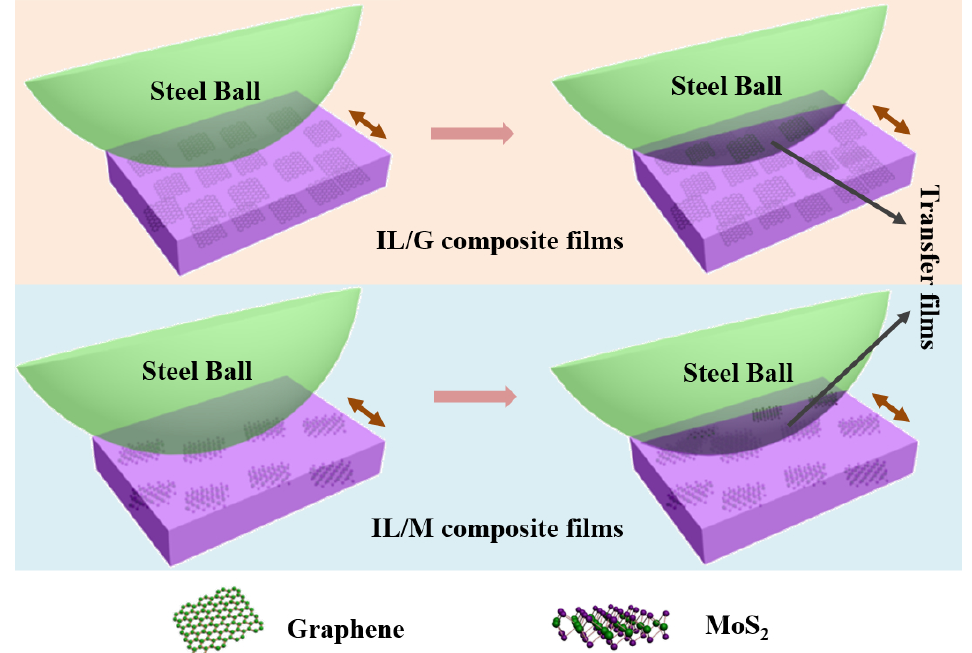
Figure 8. Schematic illustration of the tribological mechanism of the IL composite